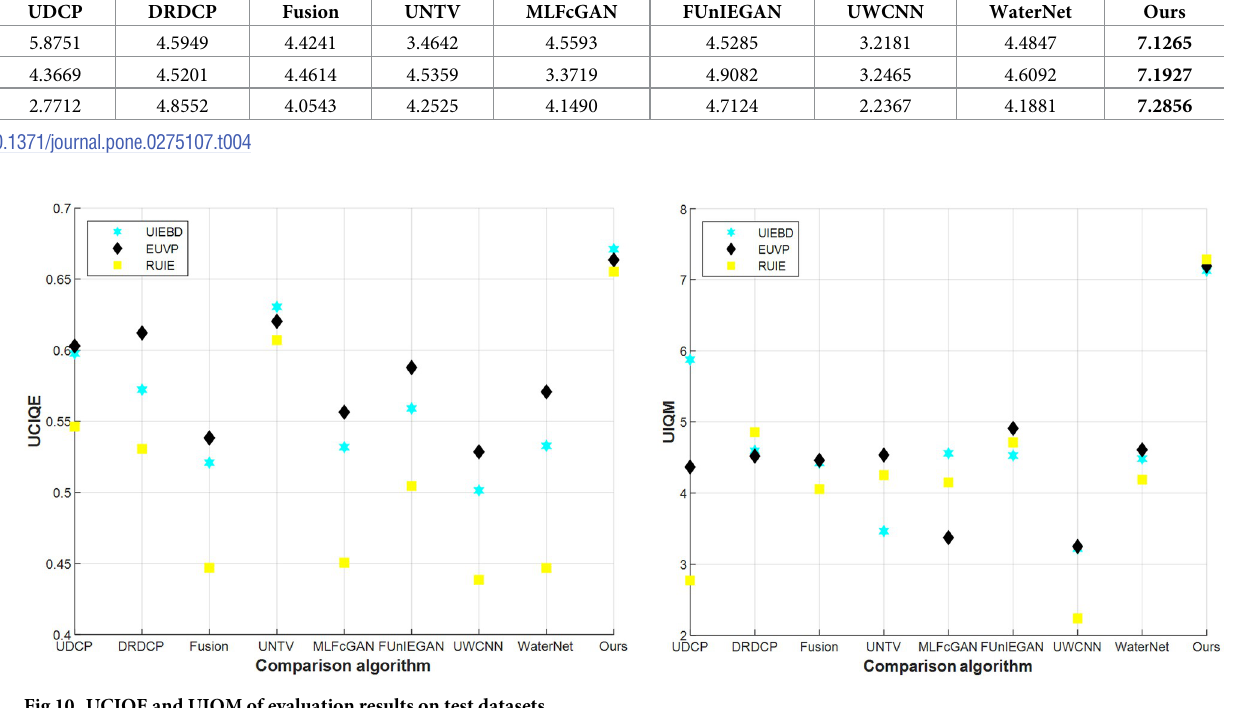
Fig 10. UCIQE and UIQM of evaluation results on test datasets.